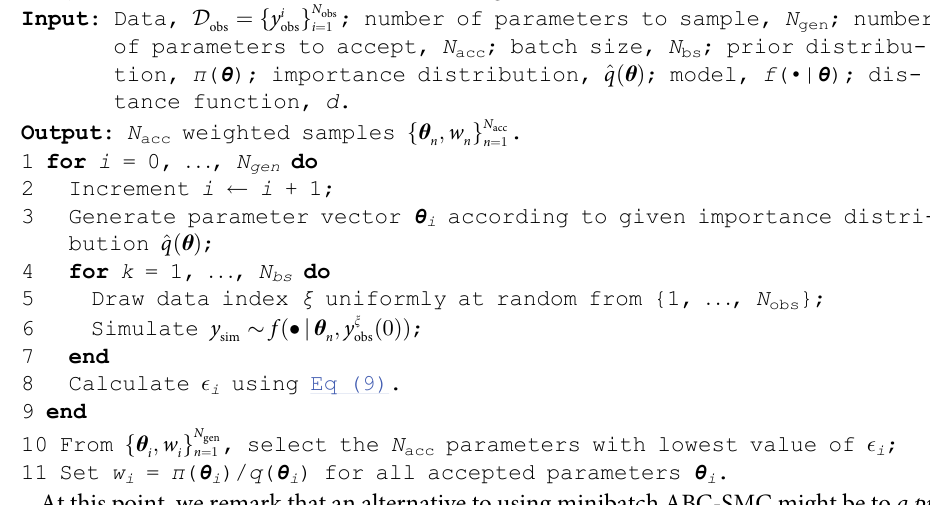
Algorithm 1 : Minibatch-importance